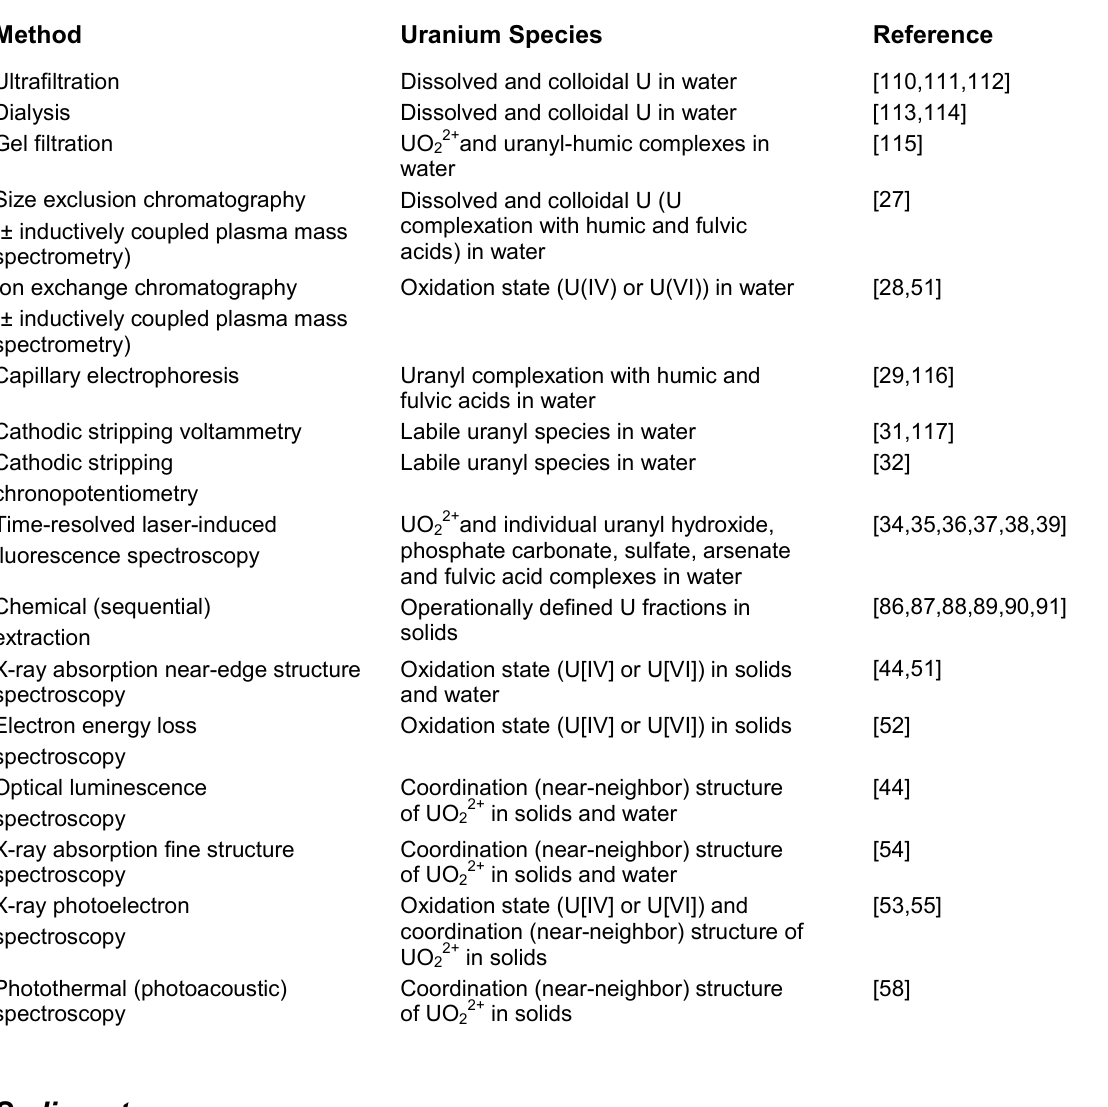
Analytical Methods Used to Determine the Speciation of Uranium (<30 (cid:181)g l -1 ) in